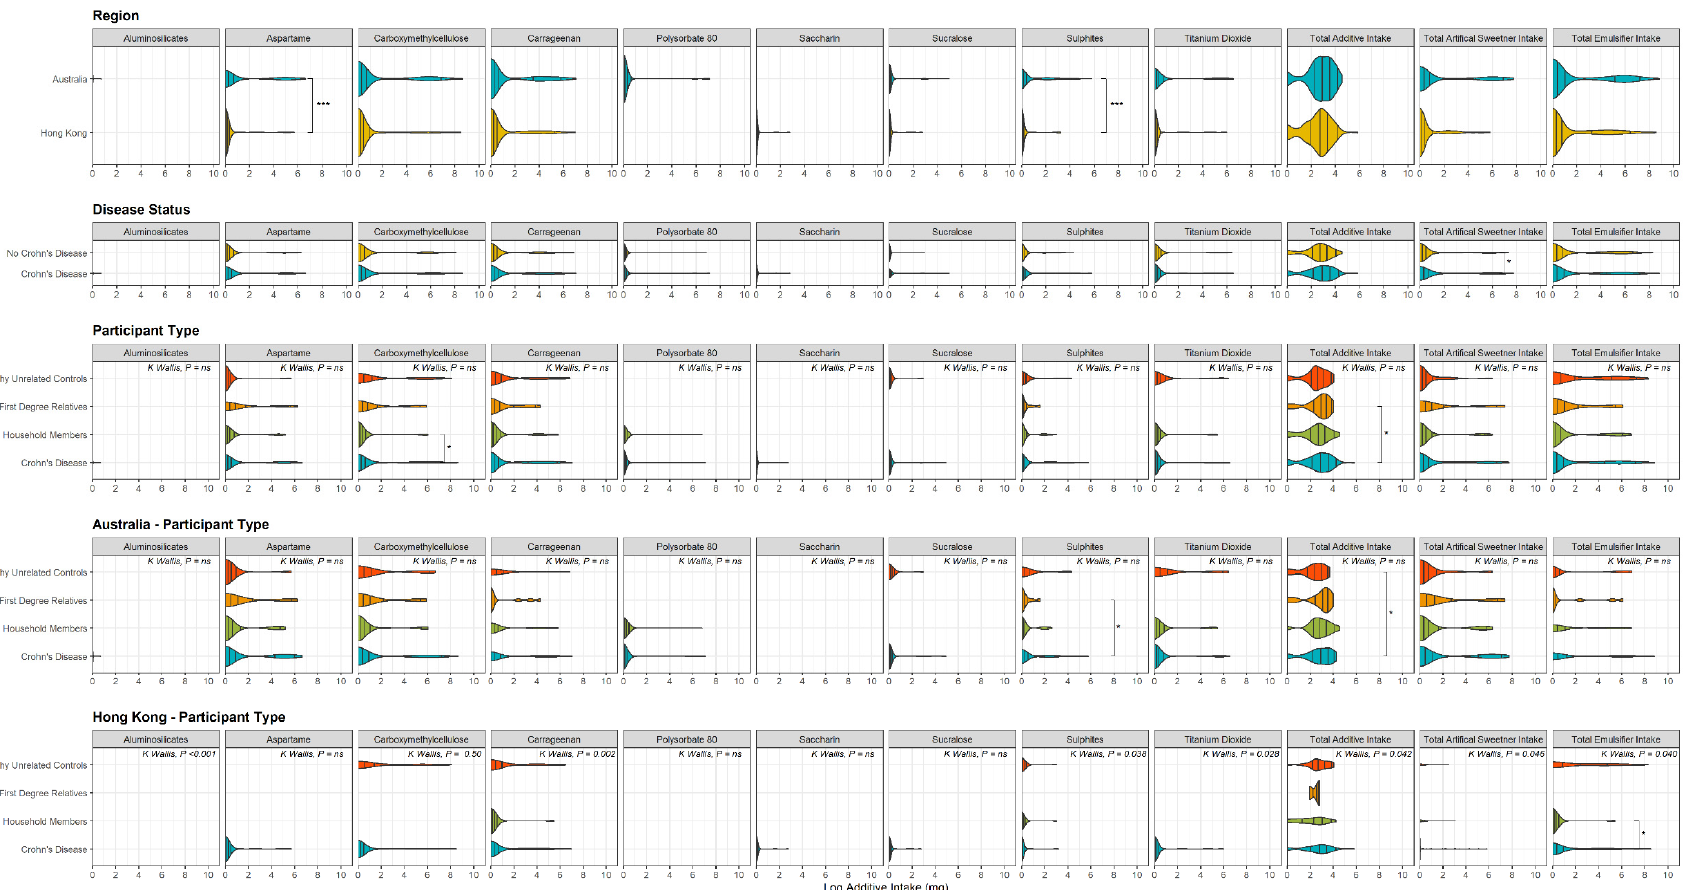
Figure 2. Violin plots showing the distribution of Log-adjusted median additive intake (in milligrams) across additives of interest (as well as total additive intake, total artificial sweetener intake and total emulsifier intake, far right panels) from current (last 3 days) intake questionnaire: between regions (top panel), for Crohn’s cases compared to all controls (Disease Status; second panel), between all participant types across both regions (third panel), and between all participant types with each region (bottom two panels). Lines represent quantiles (0.25,0.50, 0.75, 0.95), all P values calculated on unadjusted intake amounts, only significant P values shown (* p ≤ 0.05, *** p < 0.001, ns—not significant). Comparisons of ≥ 3 groups performed with Kruskal–Wallis test, between group comparisons calculated with Mann–Whitney U or Wilcoxon sign-rank